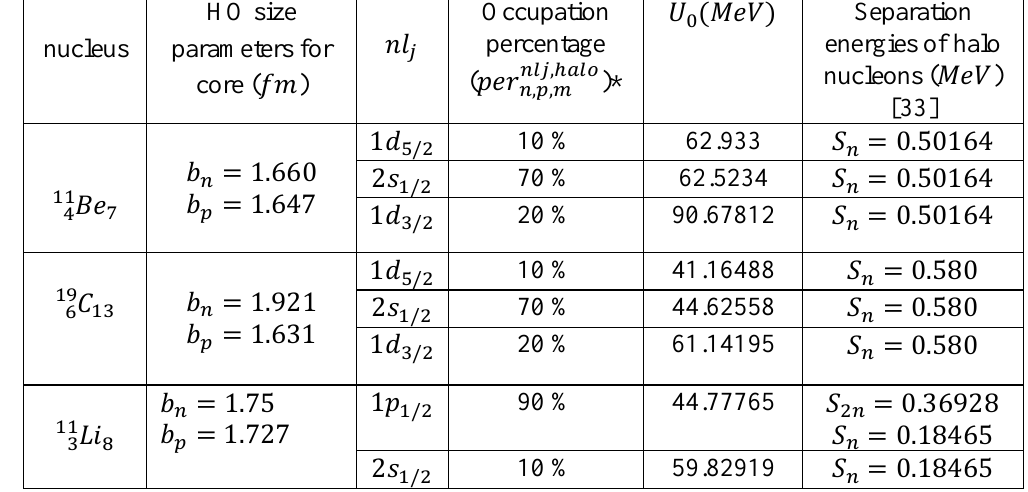
Table 2: HO and WS parameters for core and halo